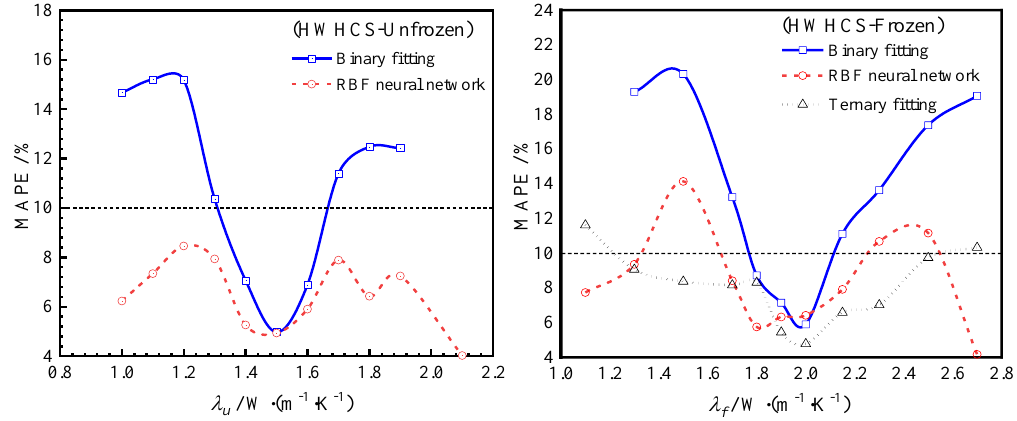
Figure 14. Mean absolute percent error (MAPE) distribution of HWHCS.